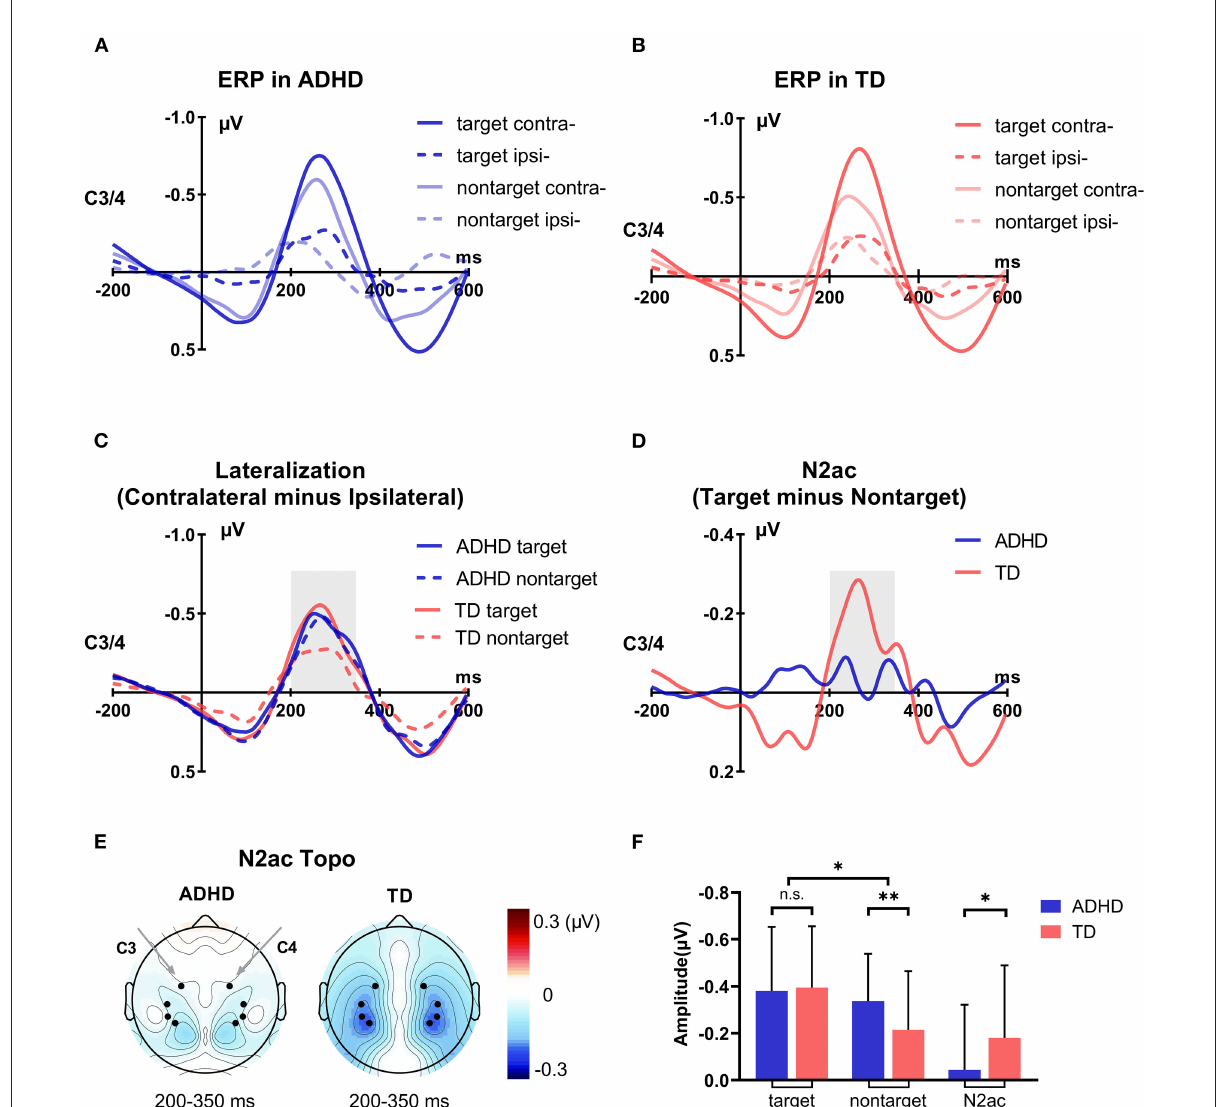
FIGURE5 Group difference in electrophysiology results. (A) The grand-average ERPs at contralateral and ipsilateral electrode sites to the target deviants and non-target deviants of the ADHD group. (B) The grand-average ERPs at contralateral and ipsilateral electrode sites to the target deviants and non-target deviants of the TD group. (C) The grand-average contralateral-minus-ipsilateral difference waveforms of the (non)target deviants in the two groups, namely, the lateralization effect. (D) The grand-average target-minus-non-target difference waveforms of the lateralization effect, namely, the N2ac component. (E) The corresponding topographic maps of the N2ac component of the two groups. (F) Statistical analysis results of the ERP data (target lateralization, non-target lateralization, and N2ac component). * p < 0.05; ** p <